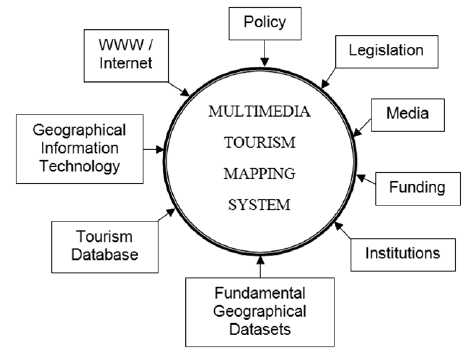
Fig. 8. Components of a multimedia tourism mapping